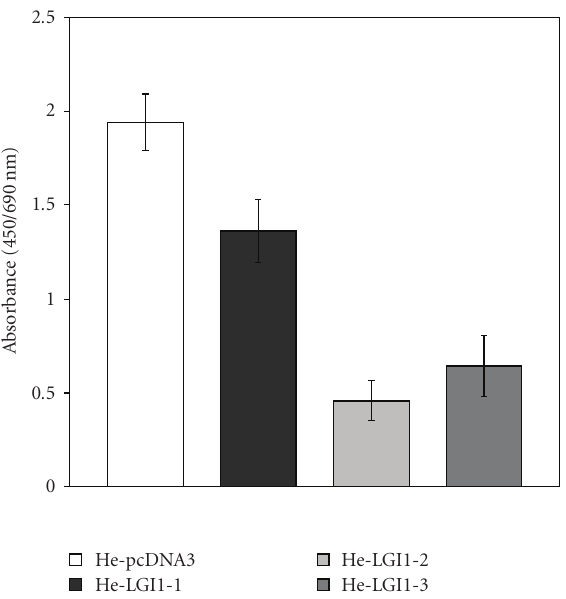
Figure 2: Cell proliferation. Cell clones He-LGI1-1, -2, and -3 and control cells He-pcDNA3 were analyzed by the BrDU incorporation procedure. Proliferation of HeLa cells expressing LGI1 was significantly lower than that of control cells ( n = 6–11; P < .